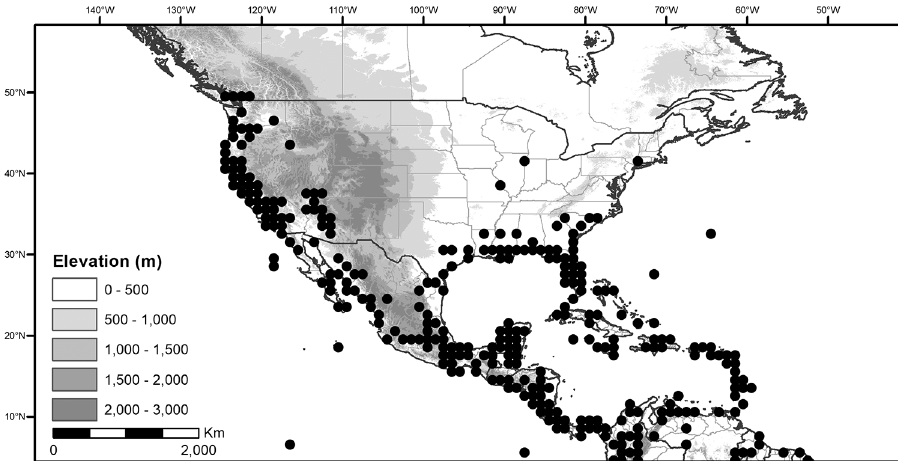
Figure 5. Distribution of Solanum americanum Mill. (points in northern South America included to show continuous